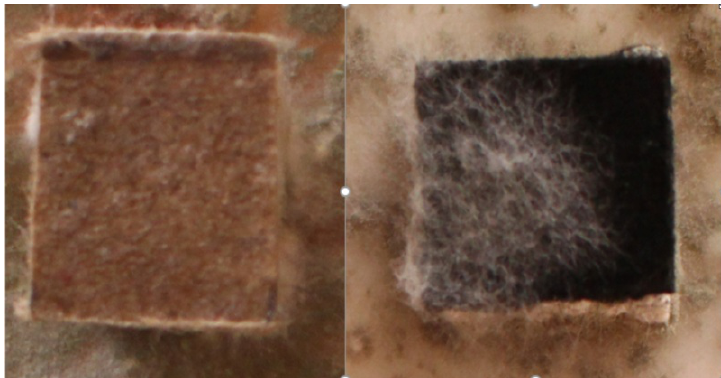
Figure 5. Sample 3 after 11 (left) and 25 (right) days.